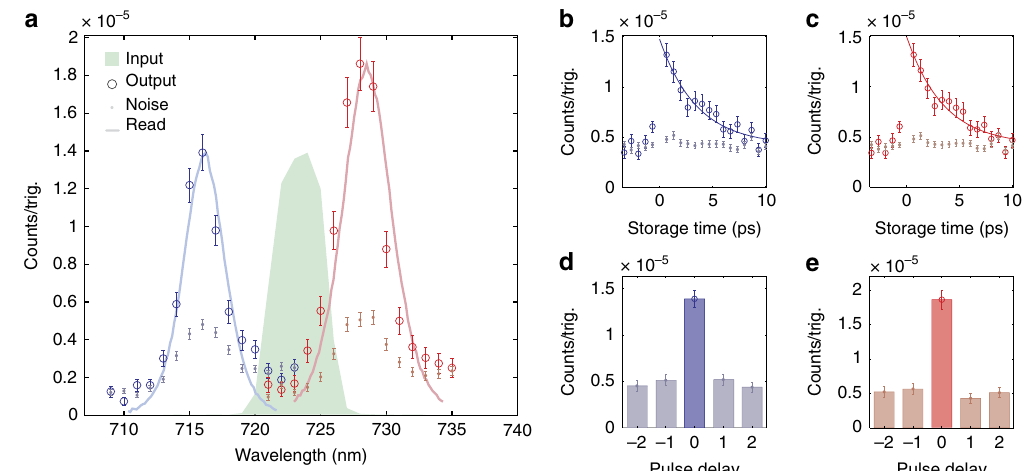
Figure 2 | Frequency conversion. ( a ) The measured blue- and red-shifted output photon spectra (hollow circles), and noise (dots), when the read beam is tuned to 792 and 808nm, respectively. Corresponding read beam spectra, blue-shifted by the phonon frequency, are shown (solid lines) for reference along with the input photon spectrum (green). ( b ) Retrieved blue- and ( c ) Red-shifted signal (hollow circles), and noise (dots), as read–write delay is scanned. An exponential fit gives a phonon lifetime of 3.5ps. ( d ) Coincidence detection events between blue- and ( e ) red-shifted output and herald photons while scanning the electronic delay between them, as measured at the peak of the spectrum. ( a – e ) Error bars show 1 standard deviation calculated assuming Poissonian